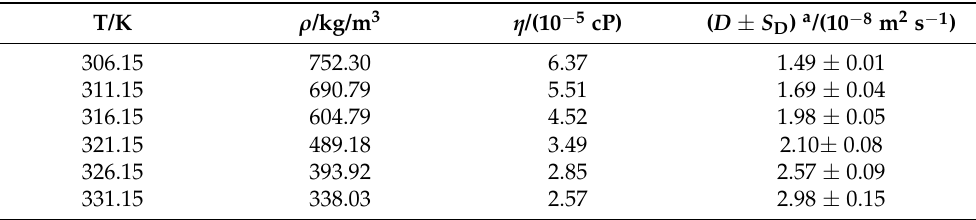
Table 1. Measured diffusion coefficients D for ethanol in supercritical CO 2 at pressure p =10.5 MPa and calculated density ρ and viscosity η [38] for supercritical CO 2 at different temperatures from 306.15 to 331.15